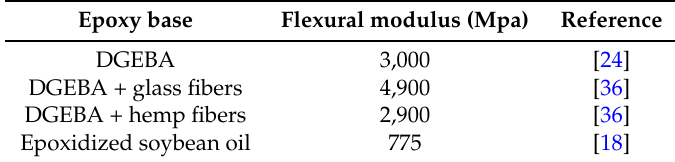
Table 3. Flexural modulus values of epoxy based thermosets measured in 3 point bending mode.